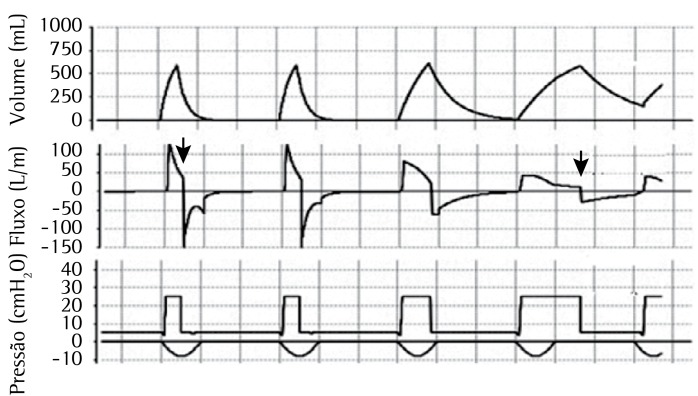
Assincronias de ciclagem durante a pressão de suporte. No primeiro
ciclo, o ponto de corte de 25% do pico fluxo foi atingido rapidamente
(porcentagem de critério de ciclagem), fazendo com que o tempo
inspiratório do ventilador tenha sido menor que o desejado pelo paciente.
Isso pode ser observado pela porção expiratória da curva de fluxo, que
tende a voltar para a linha de base em função do esforço ainda presente
do paciente. O último ciclo representa o contrário, ou seja, ciclagem
tardia. A redução do fluxo se faz de forma muito lenta, fenômeno típico
de obstrução ao fluxo aéreo, fazendo com que o limiar de ciclagem demore
a ser atingido. Algumas vezes o ciclo é interrompido pela contração da
musculatura expiratória, que gera uma elevação acima da pressão de
suporte ajustada ao final da inspiração (não representada nesta figura).
Figuras obtidas pelo Xlung.net, simulador virtual de ventilação mecânica.
Disponi´vel em: http//:www.xlung.net.